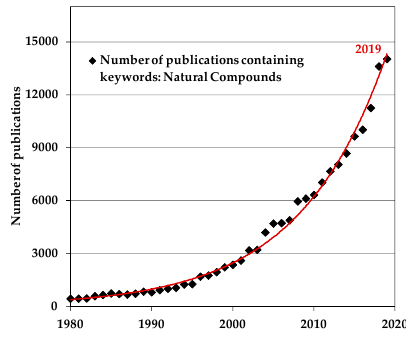
Figure 1. The trend of published papers vs. publication year (Scopus data revelation in January 2020).